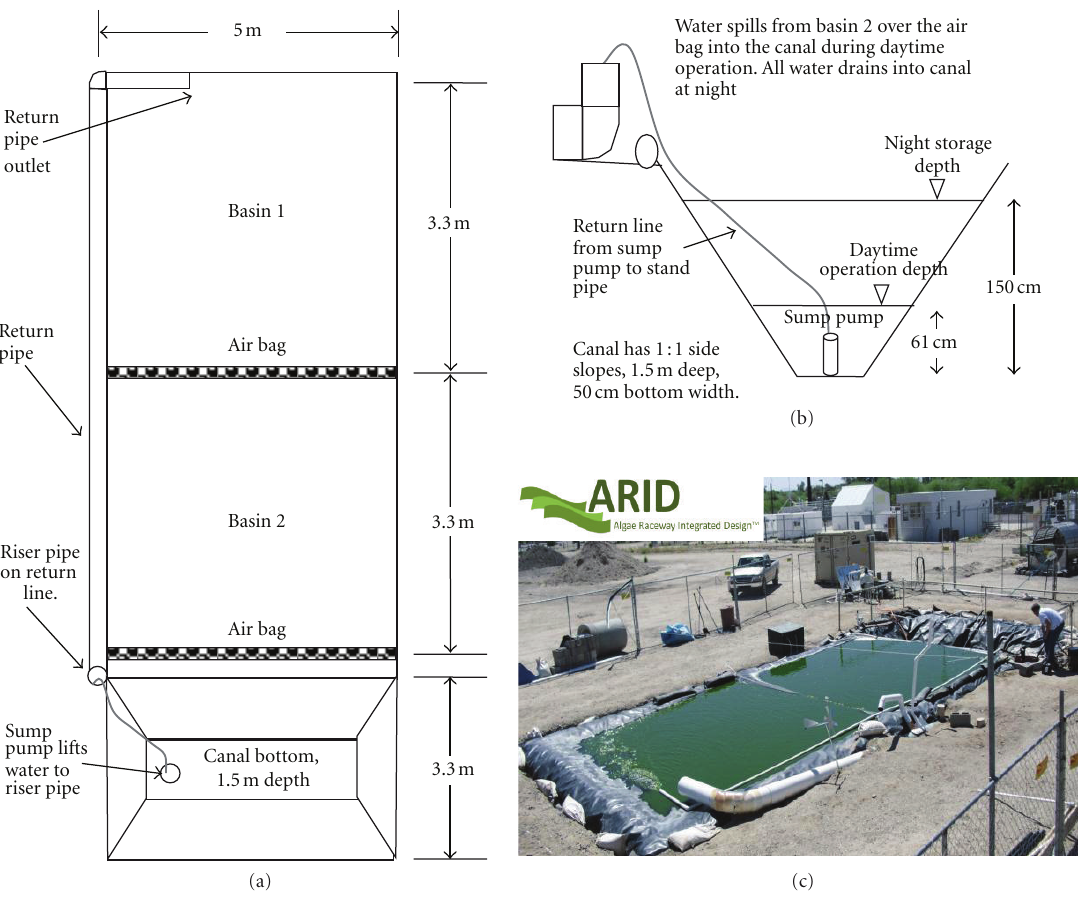
Figure 1: (a) ARID pond schematic. (b) Detail of ARID pond canal, showing water depths during day and night operation. (c) Photo from N. salina batch culture